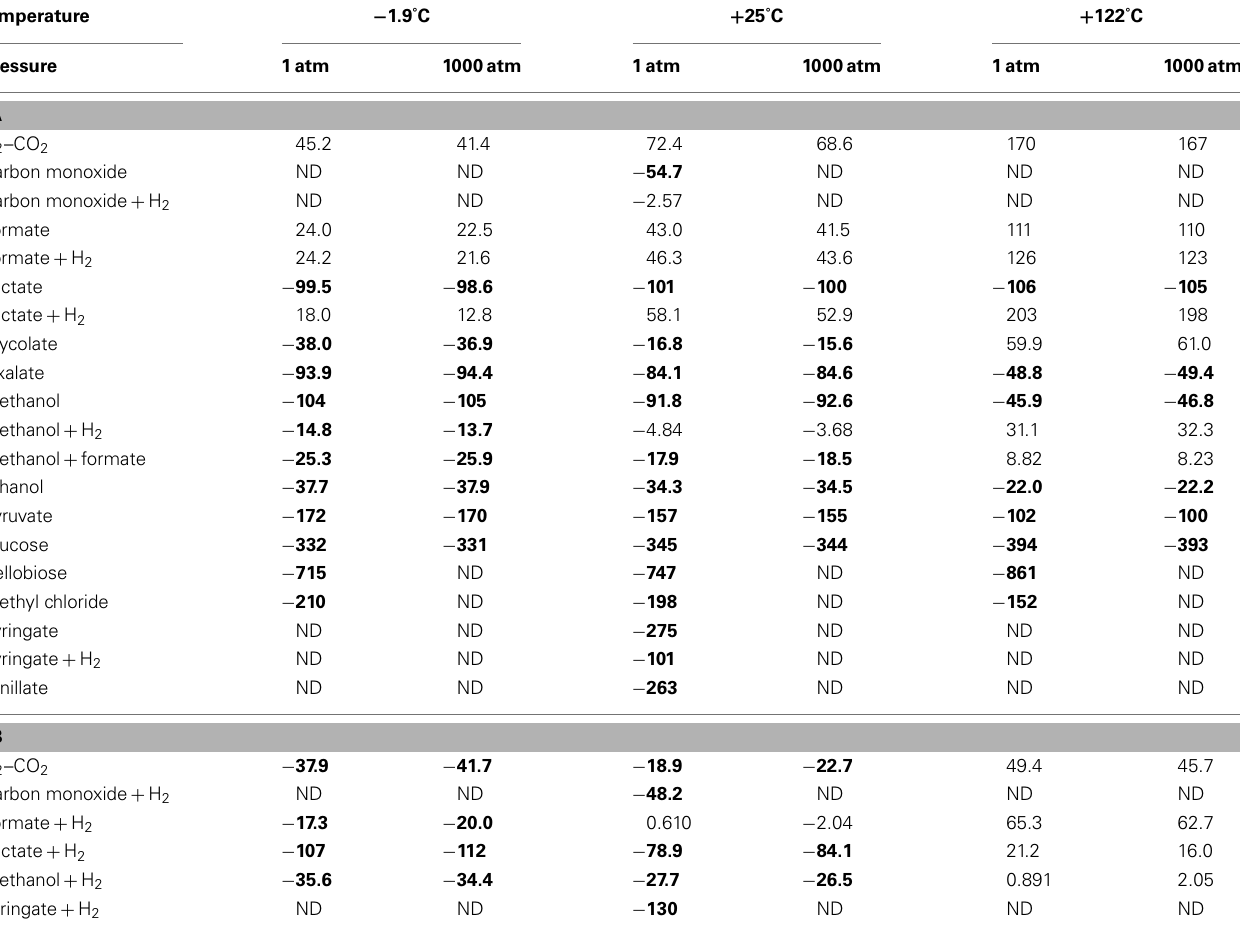
Table 3 | Gibbs free energy yields of the various acetogenesis reactions at a wide range of temperatures, pressures, and H 2 concentrations.